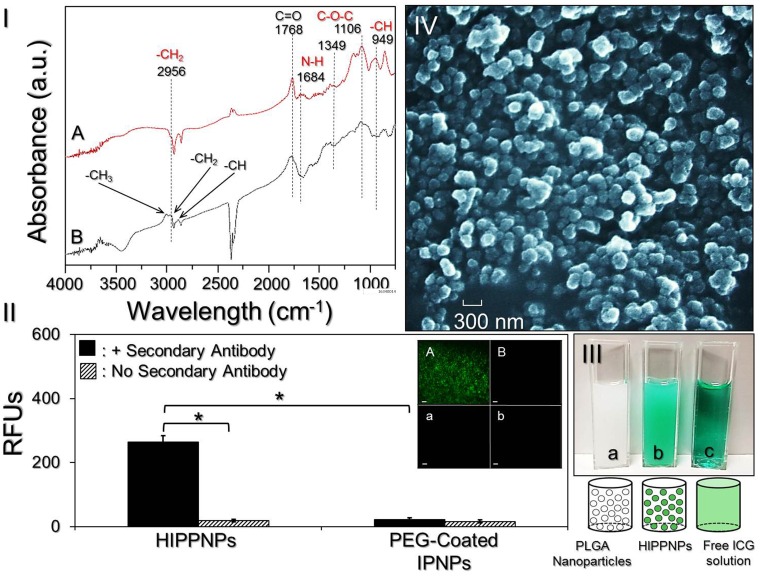
Assessment of physicochemical properties of HIPPNPs.(I) The FTIR absorption spectra of IPNPs with (A) and without (B) PEG conjugation on the nanoparticle surface. (II) Verification of presence and bioactivity of anti-HER2-mAbs on the HIPPNPs. The inset photographs represent fluoromicroscopic images of HIPPNPs (A/a) and PEG-coated IPNPs (B/b) with (A/B) and without (a/b) conjugation of fluorescent anti-mouse IgG secondary antibody at 200X magnification. Scale bar = 10 μm. The intensity of fluorescence expressed in each group was measured by spectrofluorometry performed with excitation wavelength of 488 nm and emission wavelength of 525 nm, and quantitatively represented by RFUs. Values are mean ± SD (n = 3). *P < 0.05. (III) Photographs and schematic diagrams of blank PLGA nanoparticles in PBS (a), HIPPNPs after washed with PBS (b), and freely dissolved ICG in PBS (c). (IV) SEM image of the HIPPNPs.